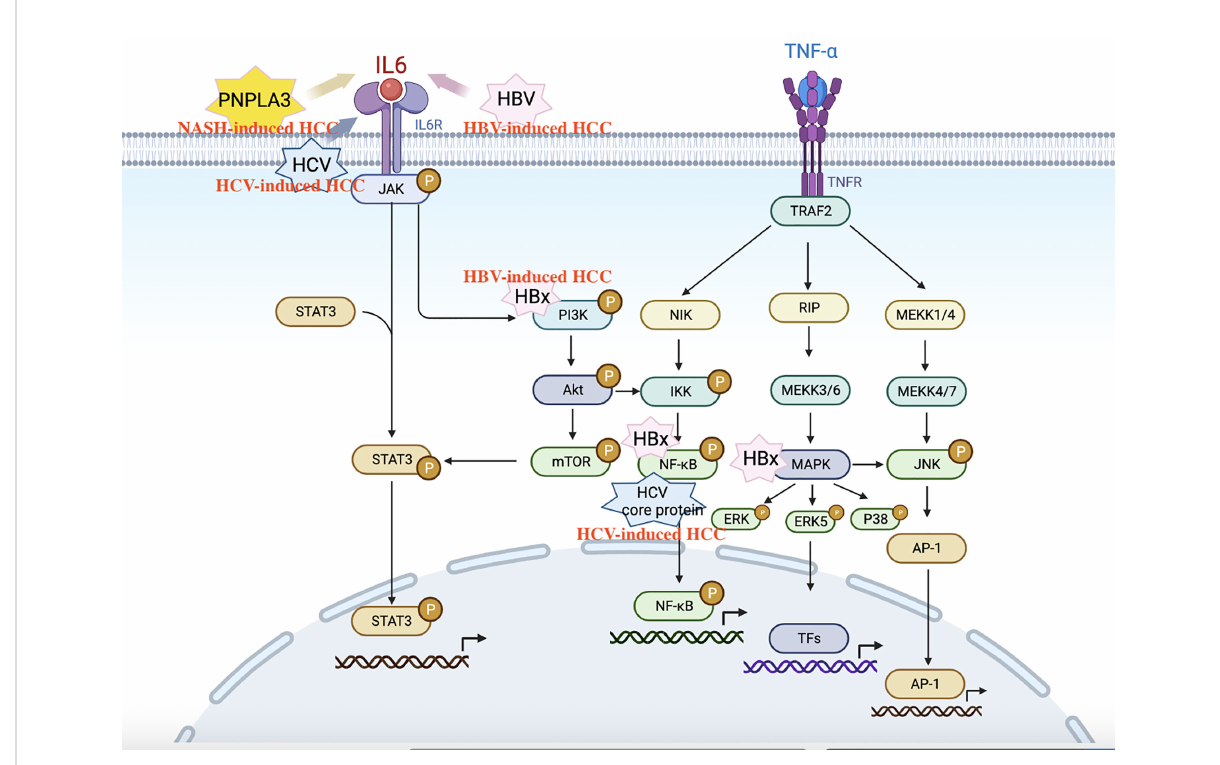
FIGURE 4 Schematic diagram of IL6 and TNF- a in fl ammatory pathways in HBV, HCV, NASH-induced HCC. IL-6, Interleukin-6; TNF- aa Tumor necrosis factor-alpha; HCC, Hepatocellular